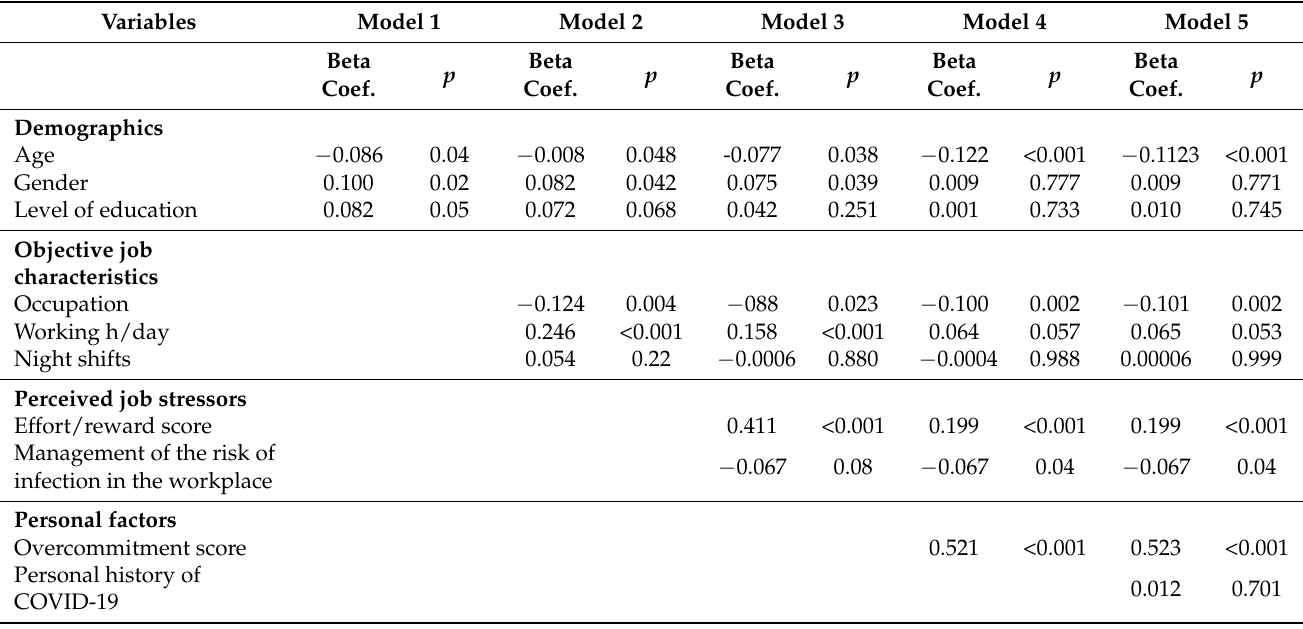
Table 5. Regression models of the correlation between the risk factors and exhaustion score in slHCW.